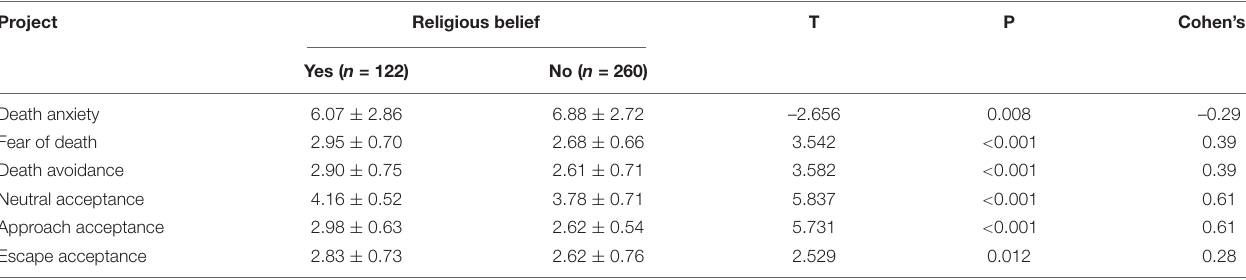
TABLE 3 | Results of death attitude and anxiety in different religious beliefs. Project